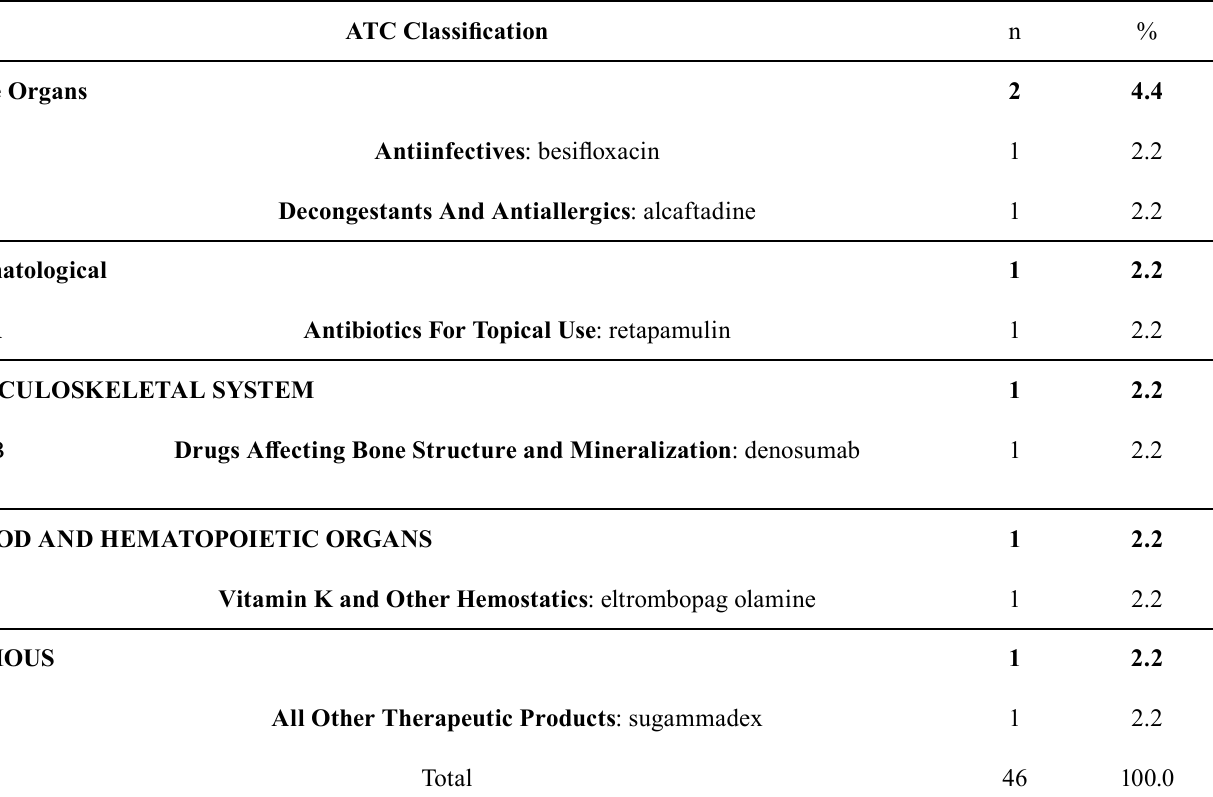
(Table II). For 16 medicines (34.8%), indication was a pediatric complex chronic condition.